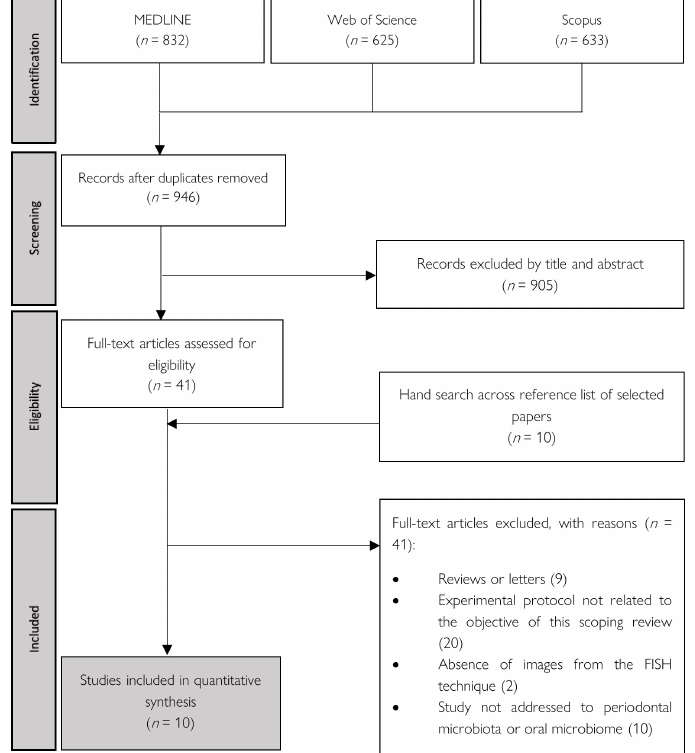
Figure 1 . Flowchart of literature search and study selection. Figure 1. Flowchart of literature search and study